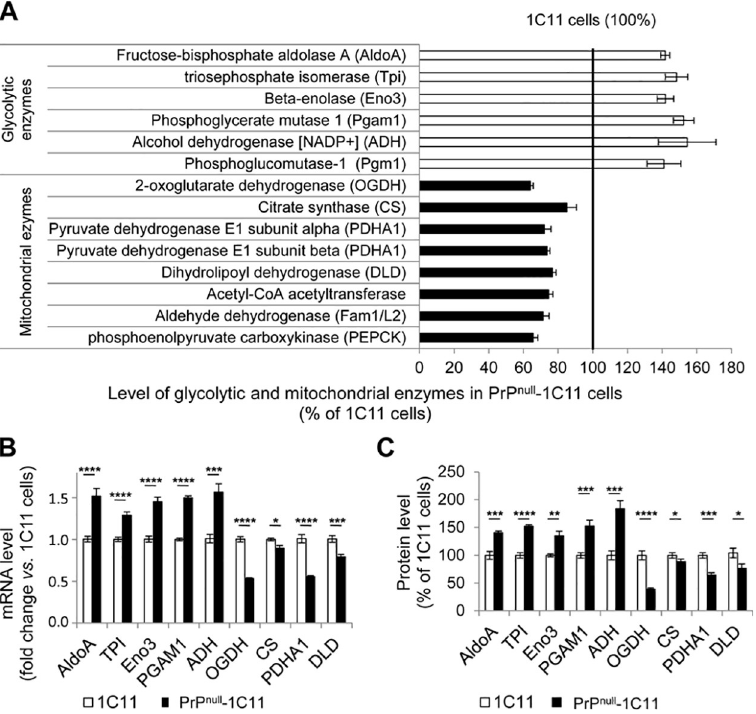
Fig 1. Loss of PrP C in the 1C11 neuronal cell line impacts on the expression of glycolytic and mitochondrial enzymes. ( A ) Relative amounts of glycolytic and mitochondrial enzymes involved in the oxidative degradation of glucose in PrP null -1C11 cells as compared to parental 1C11 cells. ( B ) Relative mRNA levels of fructose-bisphosphate aldolase A (AldoA), triosephosphate isomerase (TPI), beta-enolase 3 (Eno3), phosphoglycerate mutase 1 (PGAM1), alcohol dehydrogenase (ADH), 2-oxoglutarate dehydrogenase (OGDH), citrate synthase (CS), pyruvate dehydrogenase E1 (PDHA1) and dihydrolipoyl dehydrogenase (DLD) in PrP null - vs . 1C11 cells (n = 10). ( C ) Histogram quantifications for AldoA, Eno3, PGAM1, TPI, ADH, OGDH, CS, PDHA1 and DLD protein expression in 1C11 and PrP null -1C11 cells. α -tubulin was used for normalization (n = 7). Values are mean fold change ± SEM. � denotes p < 0.05, �� p < 0.01, ��� p < 0.001 and ���� p <